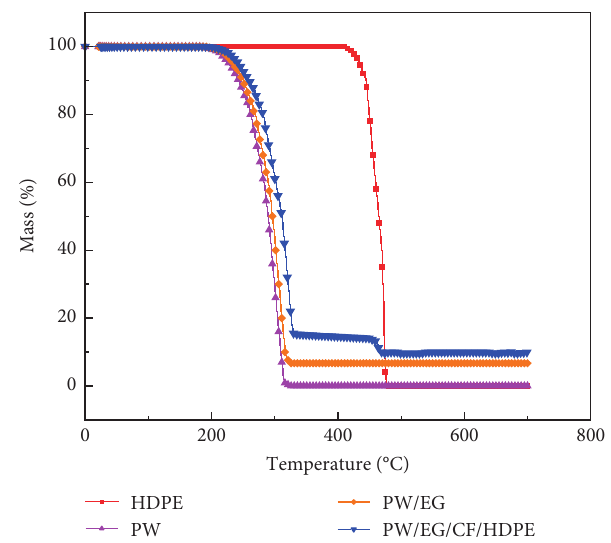
Figure 9: TG curves for the PW, HDPE, PW/EG, and